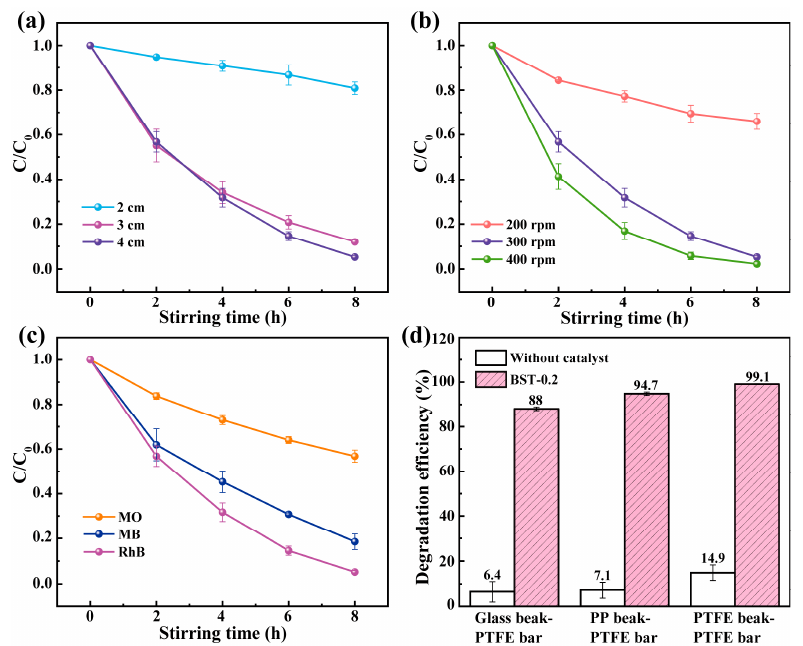
Figure 5. Effect of experimental factors on the tribocatalytic performance of BST-0.2 nanopowders: ( a ) length of the magnetic bar; ( b ) stirring speed; ( c ) type of dye; ( d ) materials of the friction pairs.